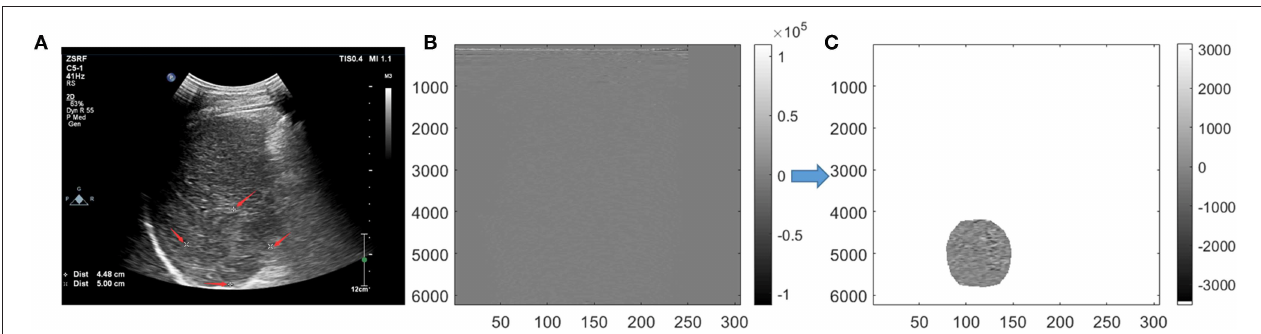
FIGURE 1 | Overall design of radiomics analysis. The radiomics analysis process consisted of the following steps: (1) grayscale images and original radio frequency (ORF) data of HCC lesions obtained; (2) tumor segmentation on grayscale ultrasound images for ORF data; (3) first feature extraction to obtain three ultrasound feature maps of ORF data of region of interest (ROI); (4) second feature extraction to obtain radiomics features from three ultrasound feature maps and related grayscale ultrasound images; (5) feature selection based on sparse representation (SR) algorithm; and (6) support vector machine (SVM) classifier trained with the selected features for MVI prediction.